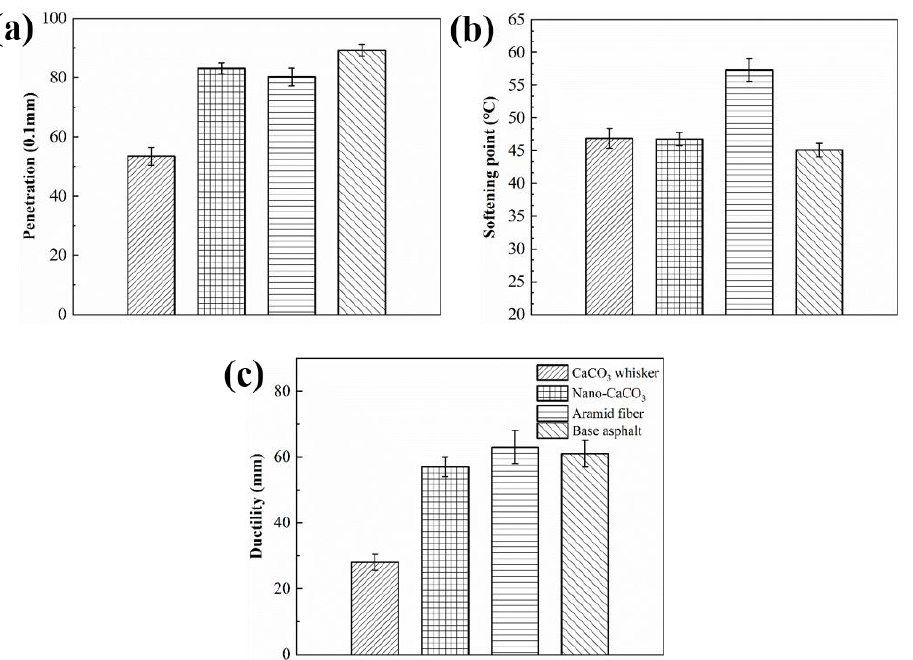
Figure 3. Conventional test results of the modified asphalt binders. ( a ) Penetration (0.1 mm), ( b ) softening point (°C), ( c ) Ductility (mm).